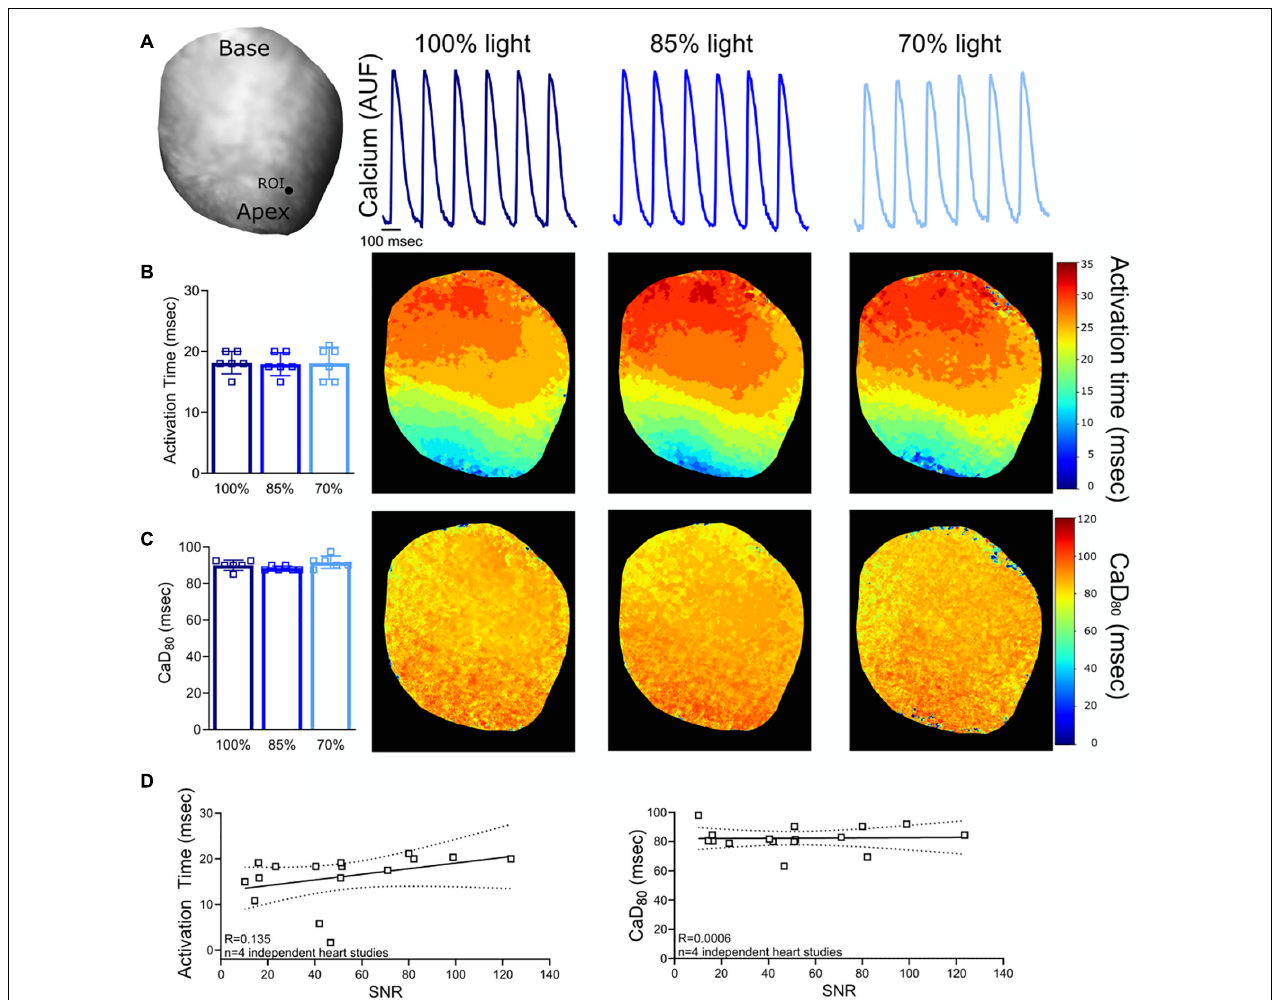
FIGURE 3 | Calcium Signal-to-Noise Ratio (SNR). (A) Representative rat heart loaded with calcium dye, Rhod-2, AM. Calcium transients were analyzed from the same region of interest (ROI) on the epicardial surface ( n = 6 calcium transients, same heart with diminished light intensity). (B) No measurable change in activation time was noted when the excitation light intensity and SNR was reduced ( n = 6 calcium transients, same heart). (C) Calculated CaD 80 values also remain unchanged ( n = 6 calcium transients, same heart). (D) Relationship between SNR and calcium transient measurements ( n = 4 optical signals collected from n = 4 independent heart studies). Epicardial dynamic pacing (160 ms PCL) from the apex of the left